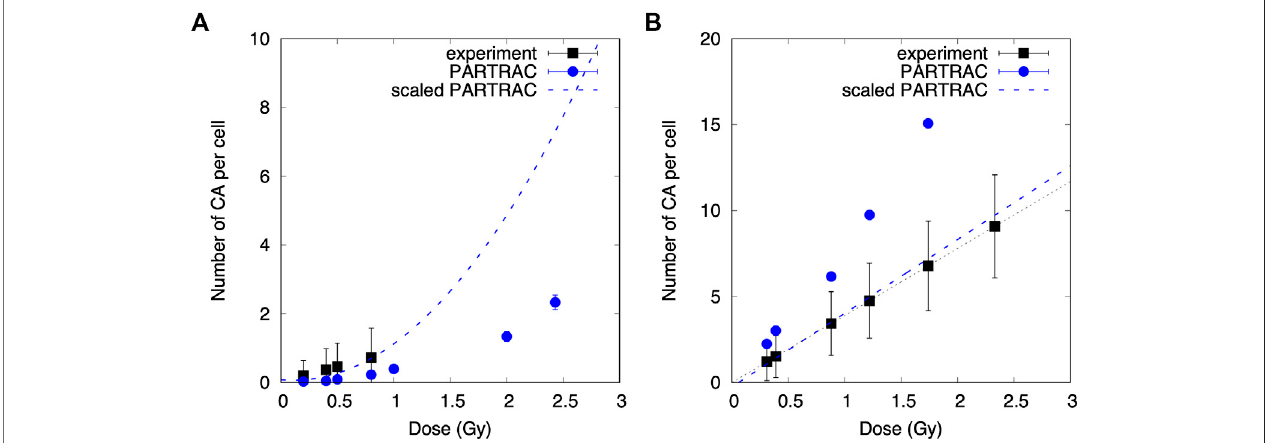
FIGURE 5 | Comparison of modeled and experimental results. Linear quadratic and linear relationships between the number of chromosomal aberrations (CA) scored for a cell induced by X-rays (A) and alpha particles (B) and the dose for experimental data and MC simulations. The blue dashed lines represent PARTRAC calculations including scaling factors.